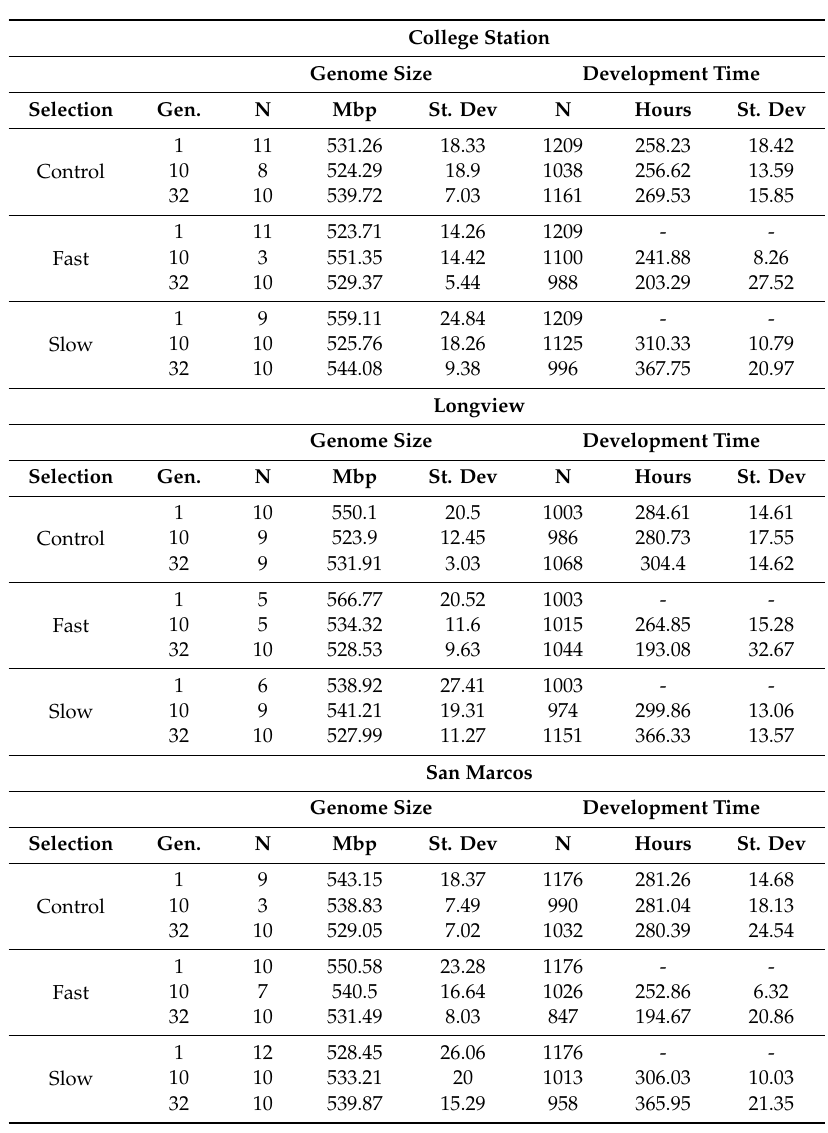
Table 2. Average genome size estimates (Mbp) and development time with standard deviations (St. Dev) of C. macellaria under developmental selection. ‘N’ represents number of individuals measured. Development time information for Fast and Slow lines from each location at Generation 1 are the same as Generation 1 in